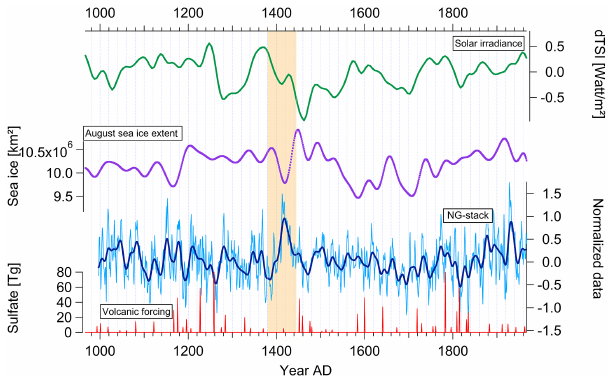
Figure 7. The northern Greenland stack (NG stack; blue: annual; dark blue: smoothed) is shown with possible forcing factors. Green represents the reconstructed total solar irradiance (Steinhilber et al., 2009), purple the reconstructed August Arctic sea-ice extent (Kin- nard et al., 2011), and red at the bottom the stratospheric sulfate aerosol injection for the Northern Hemisphere (Gao et al., 2008). All values are 40-year low-pass-filtered. The discussed AD1420 event is marked in